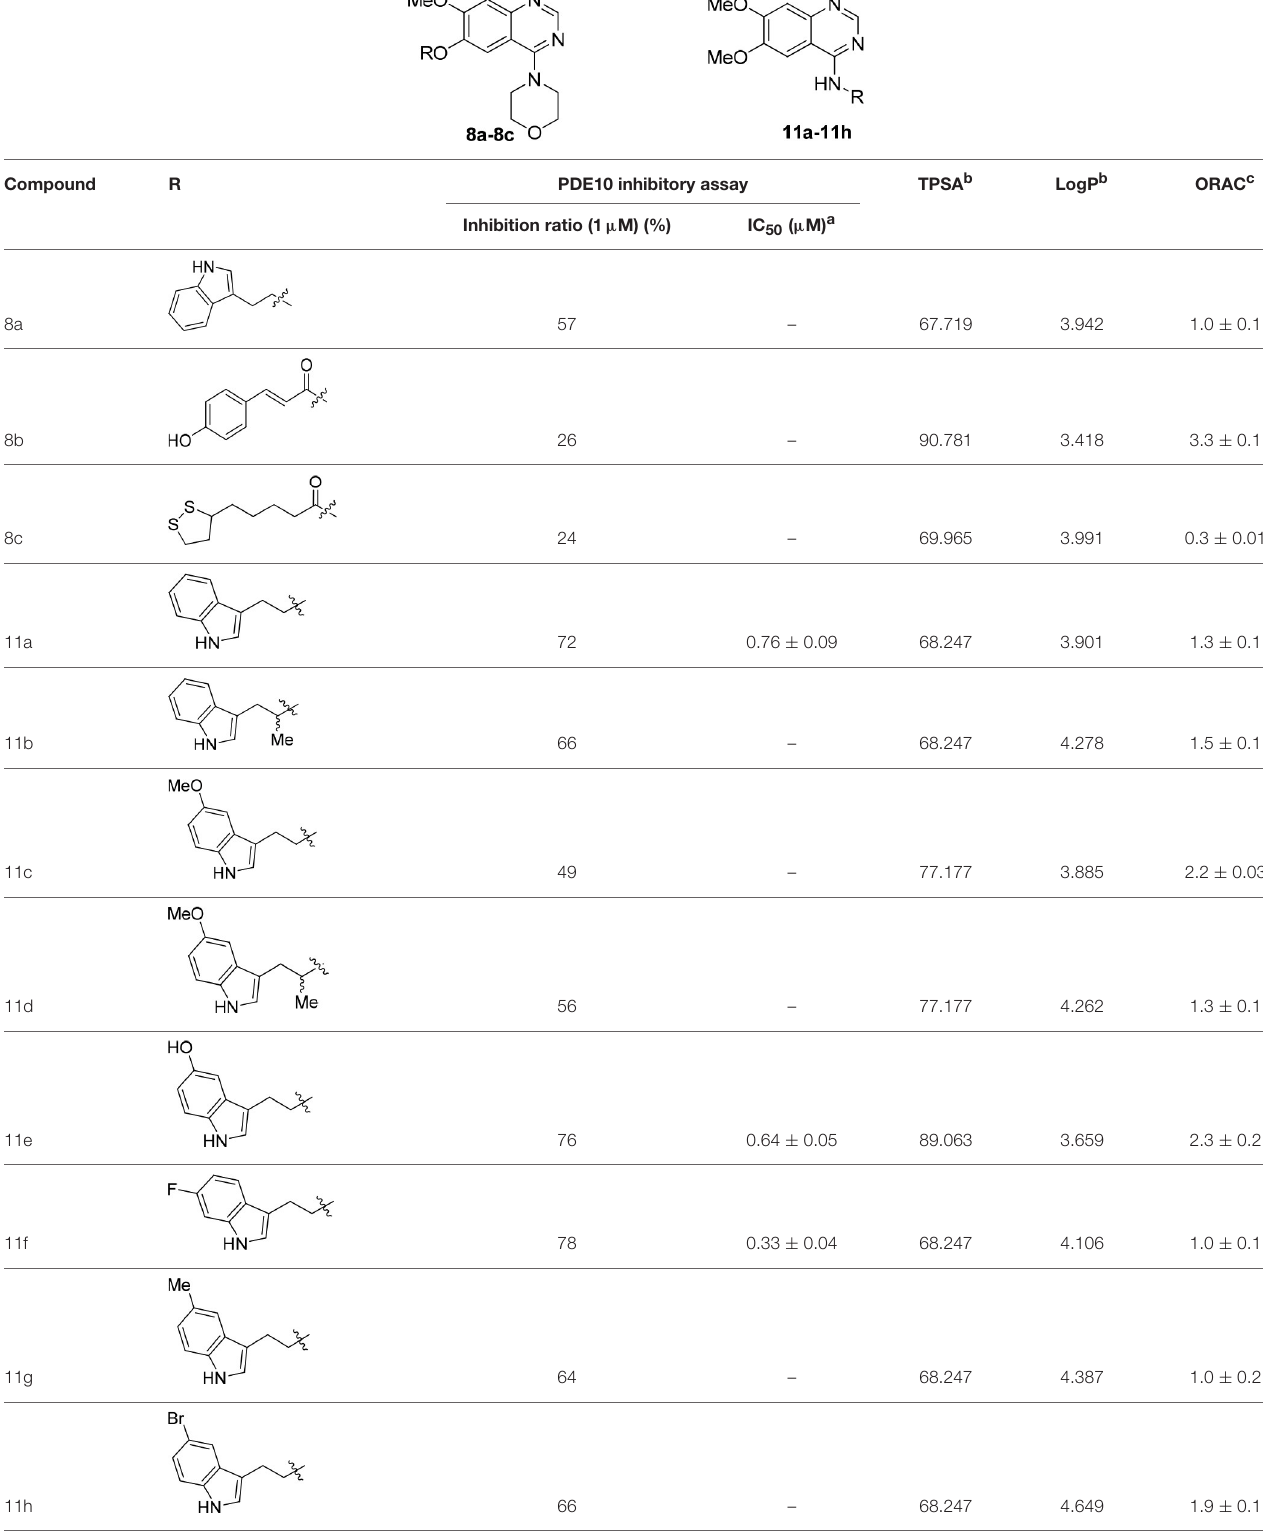
TABLE 1 | The Inhibitory activities against PDE10A, TPSA, LogP, and oxygen radical absorbance capacity of compounds 8a - 8c , 11a - 11h , 12 , and 13 .